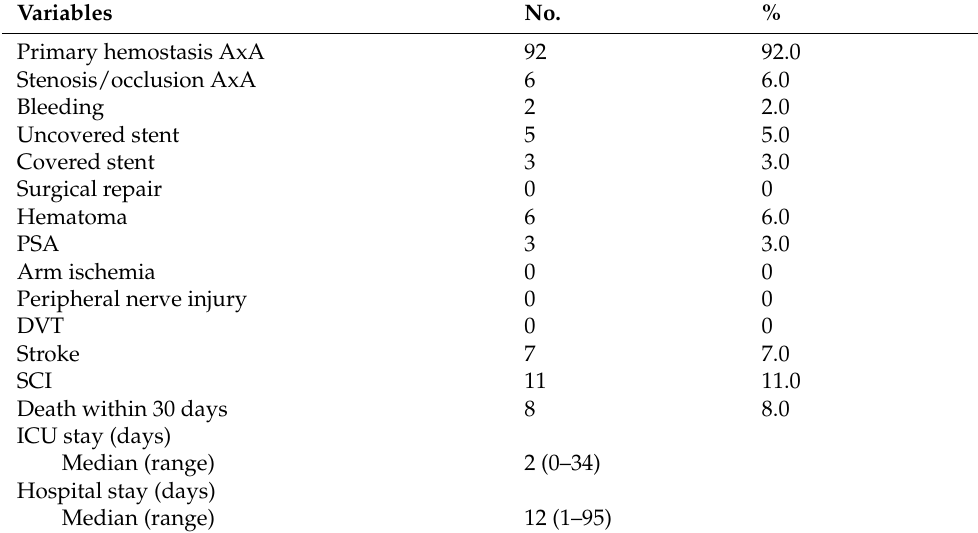
Table 5. In-hospital